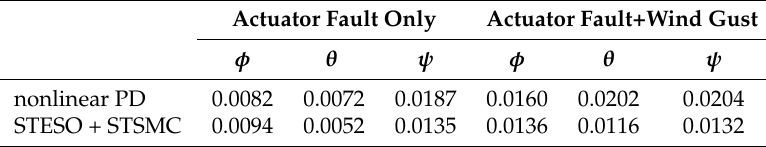
Table 3. Comparison of attitude control performance: RMS error